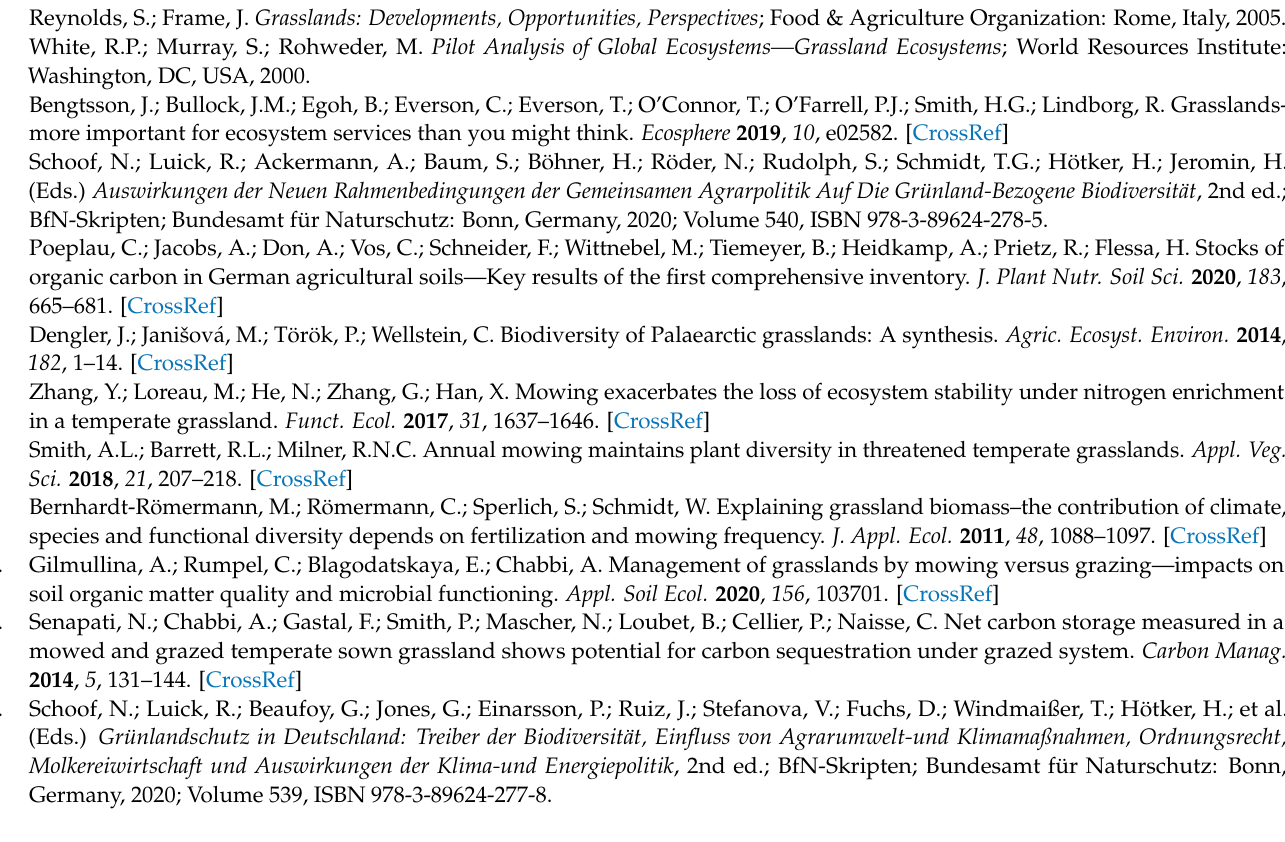
sites, Figure S5: Pre-processing flowchart of S1 and S2 parameters, Figure S6: Comparison of values before and after mowing events for all investigated